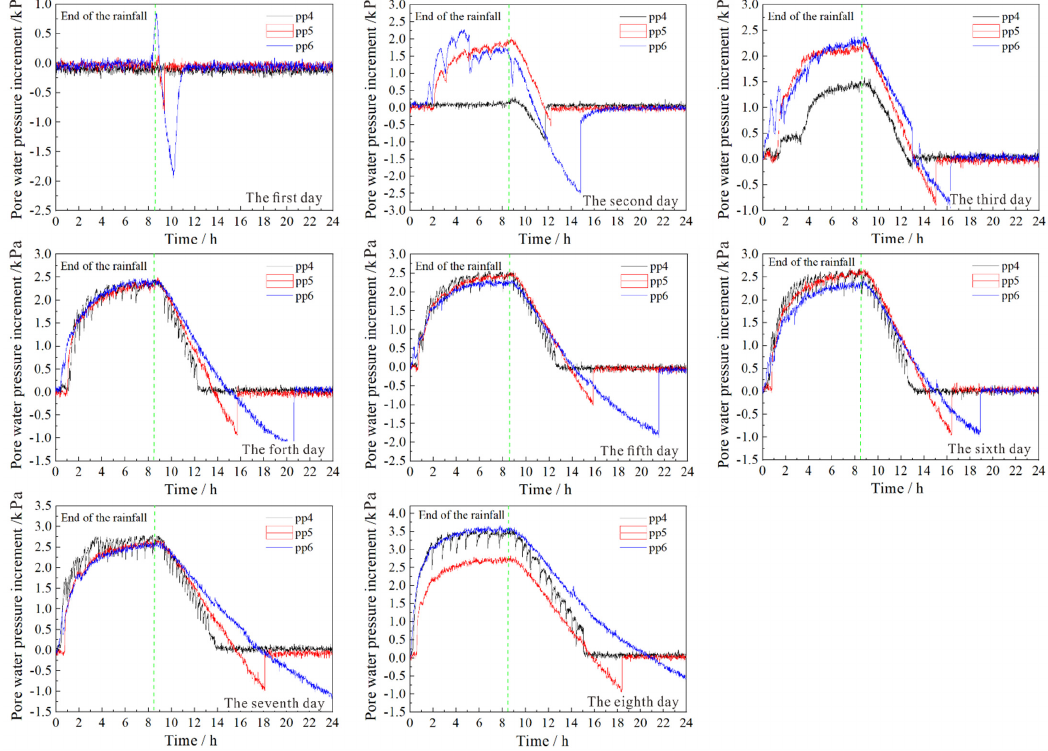
Figure 8. Variation of pore water pressure in the following days, from the first to the eighth (H2 = 0.8 m). 3.2.3. Variation of Pore Water Pressure in Slope Toe (H3 = 0.4